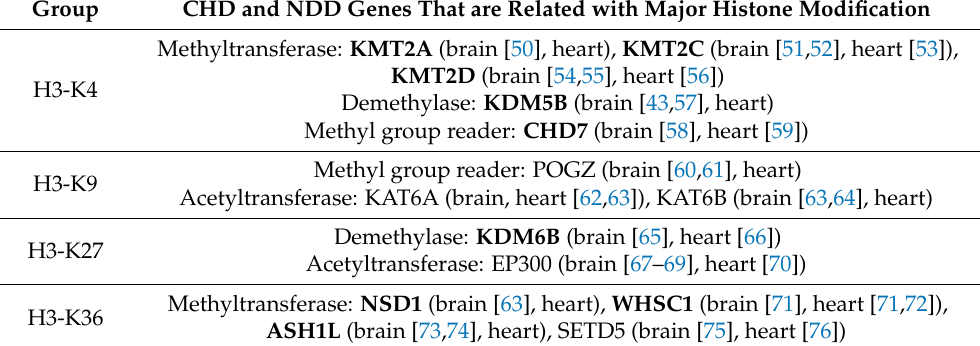
Table 1. Summary of CHD and NDD genes that are related with major histone modification. Genes that are related with PRC complex are marked bold: KMT2A, KMT2C, KMT2D, and ASH1L are trithorax group proteins that counteract with polycomb group proteins [42]. KDM5B affect bind- ing of polycomb group proteins in a subset of genes [43]. CHD7-bound regions are depleted of H3K27me3 [44,45]. KDM6B removes H3K27me3 marks [46]. NSD1 has been shown to modulate PRC2 activity [47,48]. WHSC1 has been shown to alter binding of EZH2 [49]. References that talk about heart or brain phenotype in model systems caused by mutations of corresponding gene are marked behind each